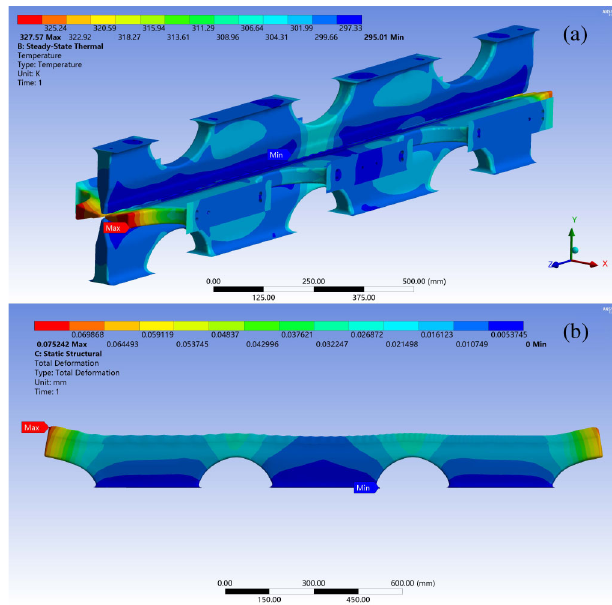
FIG. 28. (a) Temperature map and (b) deformation map of the RFQ vanes.